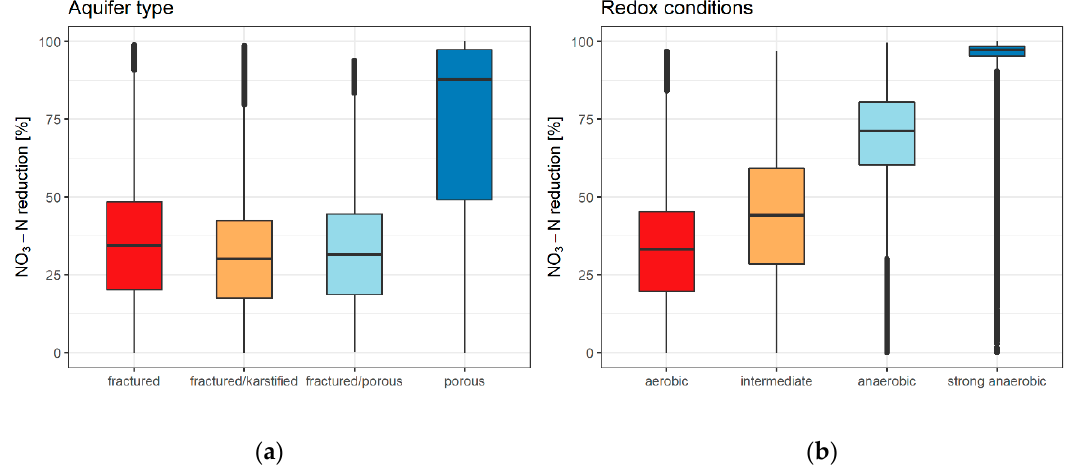
Figure 5. Boxplots of the NO 3 -N load reduction rates (%) for ( a ) aquifer type and ( b ) redox conditions.